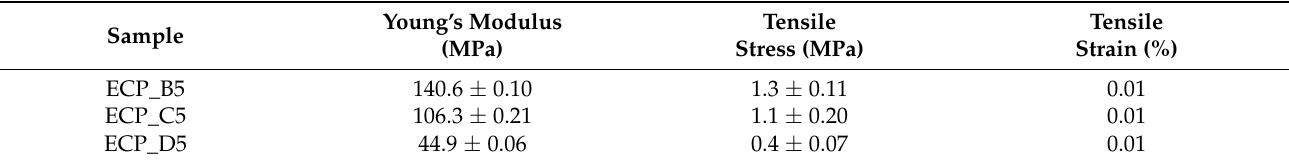
Table 6. Tensile properties for the novel composite rocket propellants.